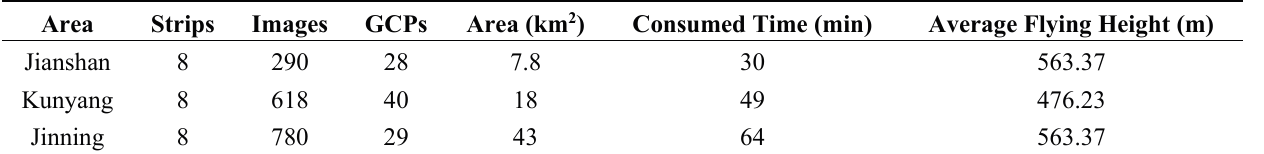
Table 3. Data acquisition achieved over the study areas.